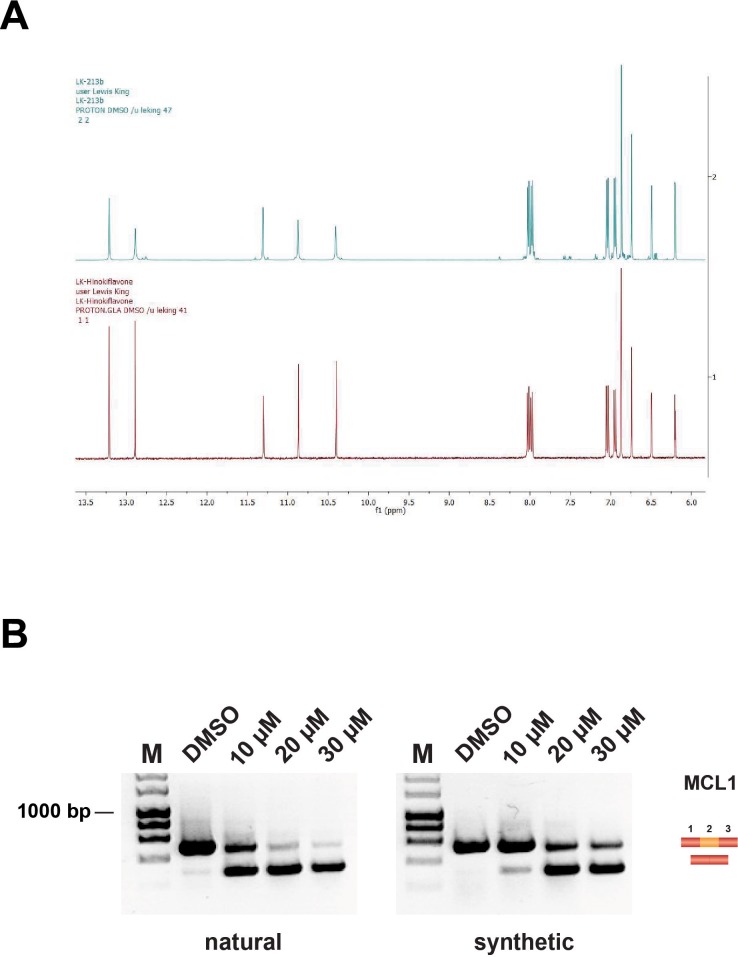
Comparison of natural and synthetic hinokiflavone.(A) Proton nuclear magnetic resonance spectrum of natural (red) and synthetic (blue) hinokiflavone. (B) Effect of natural and synthetic hinokiflavone on the alternative splicing of the MCL1 pre-mRNA in HEK293 cells.